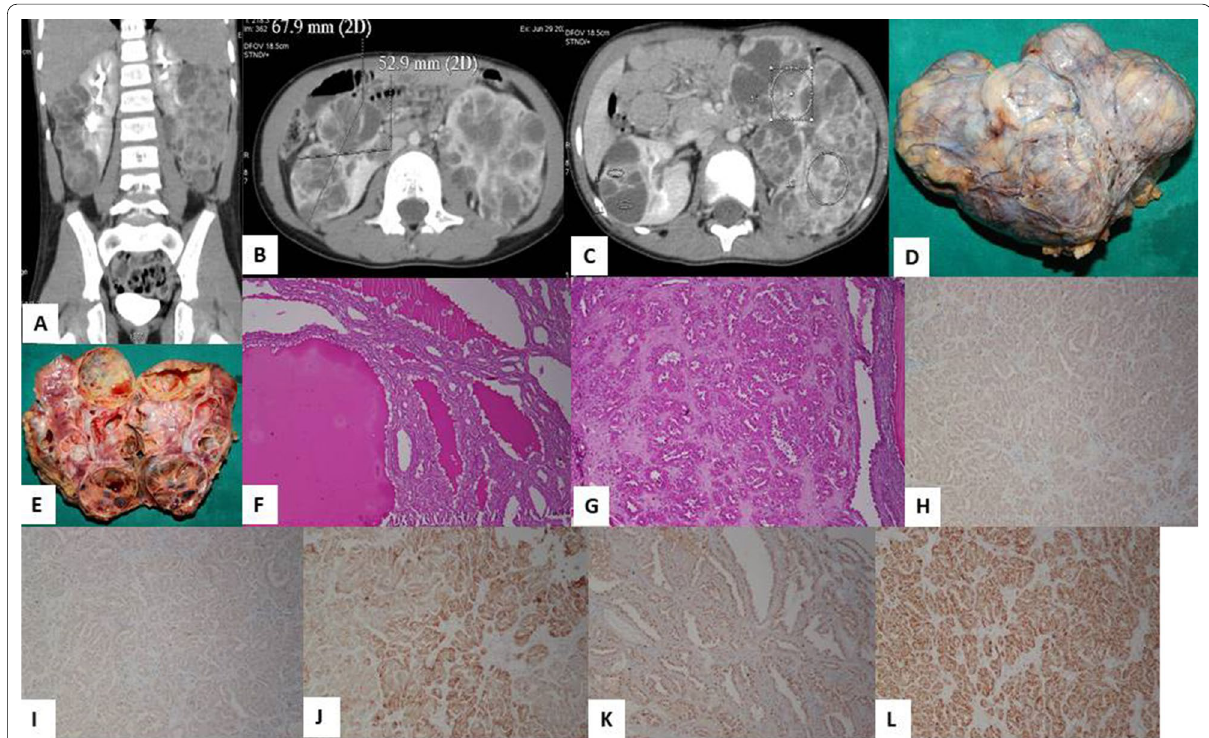
Fig. 3 A , B , C Multiple discrete variably sized heterogeneous hypodense cystic lesions in both kidneys, showing heterogeneous enhancement of solid component within lesion and septa, largest lesion in lower pole of right kidney measures 3.6 * 3.8 cm, largest lesion in mid pole of left kidney measures 4.7 * 3.6 cm. D , E 13.5 * 11 * 7.5 cm left nephrectomy specimen, on cut section, tumor mass shows partially solid and cystic masses filled with hemorrhagic fluid with focal area of hemorrhage and necrosis. F Tumor shows partially cystic areas filled with proteinaceous fluid and lined by tumor cells with eosinphilic cytoplasm. G Section from solid area shows tumor composed of nests and tubules composed of tumor cells with dense eosinophilic cytoplasm. H CK 20 negative. I CK 7 negative. J PAN-CK positive. K PAX 8 positive. L Vimentin